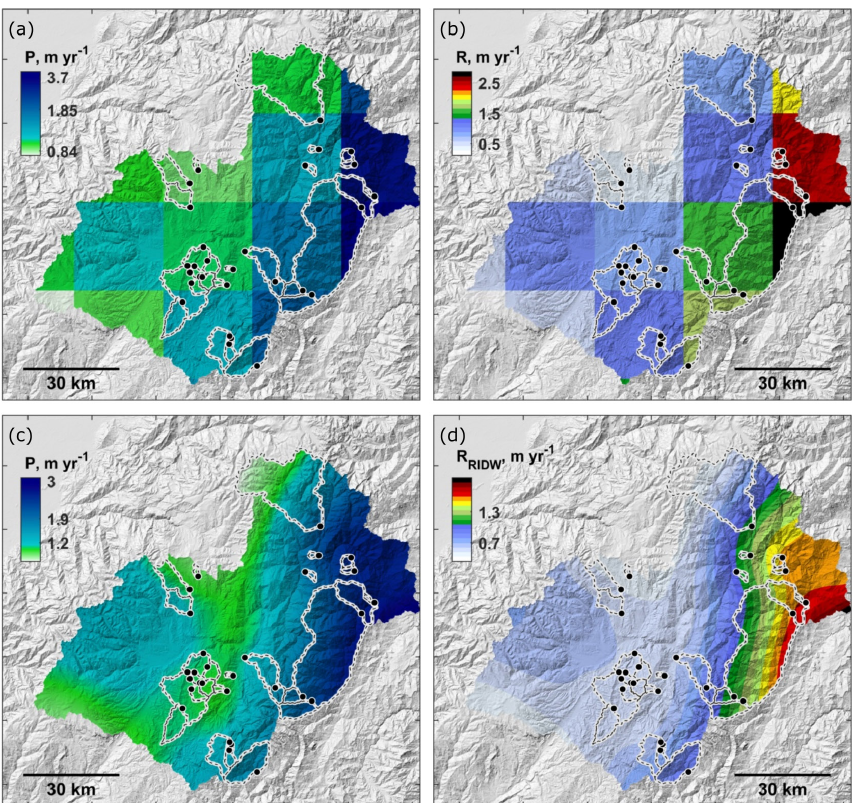
Figure 6. Downscaling of WRR2 WaterGAP3 rainfall and runoff products to high-resolution regional maps. (a) WRR2 WaterGAP3 precip- itation ( P ) at the original resolution of 0.25 ◦ . (b) Corresponding runoff ( R ) at the original resolution of 0.25 ◦ . (c) Downscaled precipitation ( P RIDW ) at a resolution of 2500m, and (d) corresponding downscaled runoff ( R RIDW ) at a resolution of 2500m. WaterGAP3 data were derived from earth2observe.eu. The underlying hillshade maps are based on the 30m SRTM v3 DEM (Farr et al., 2007). The maps are produced with Topo Toolbox (Schwanghart and Scherler,